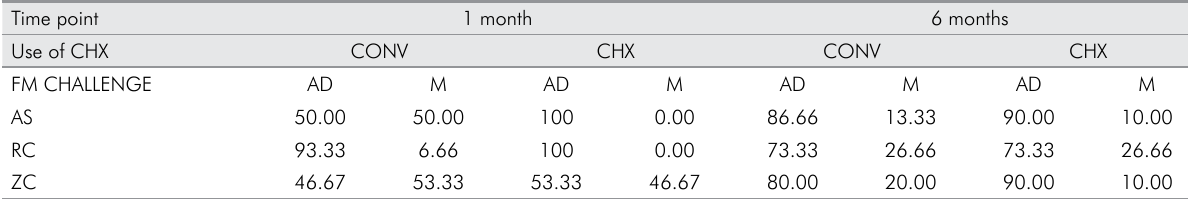
Table 3. Failure mode distribution according to challenge